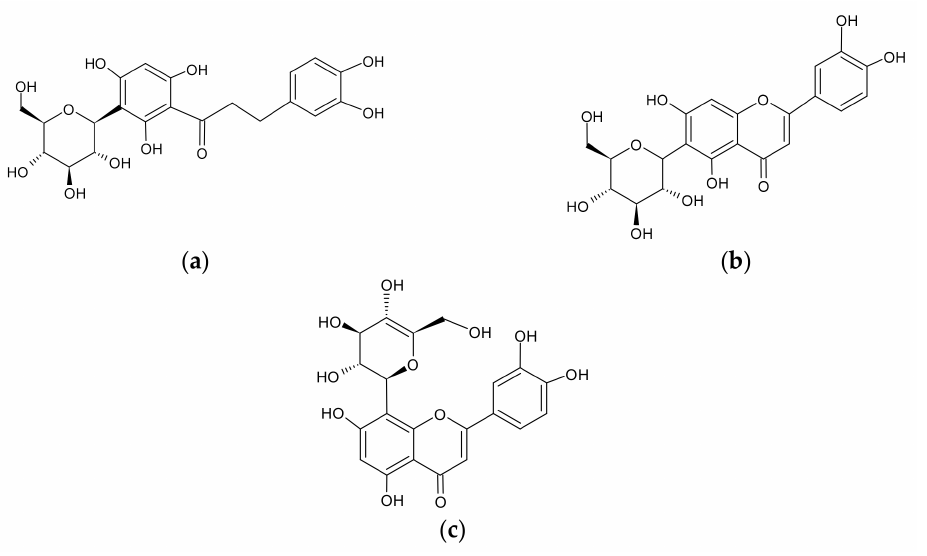
Figure 1. Chemical structures of aspalathin ( a ), isoorientin ( b ), and orientin ( c